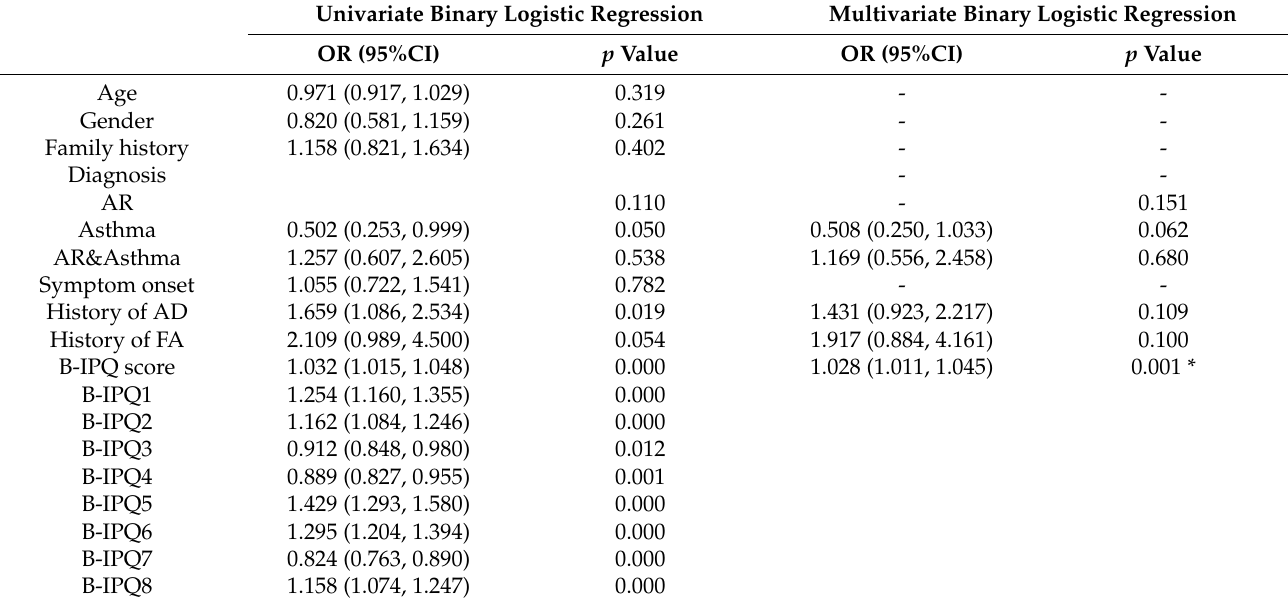
Table 3. Factors associated with health-seeking behavior (going to hospital) in participants with respiratory